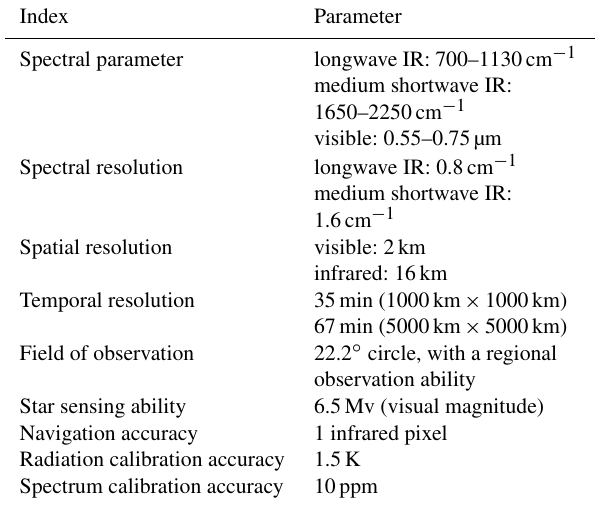
Table 3. Observation modes of AGRI.